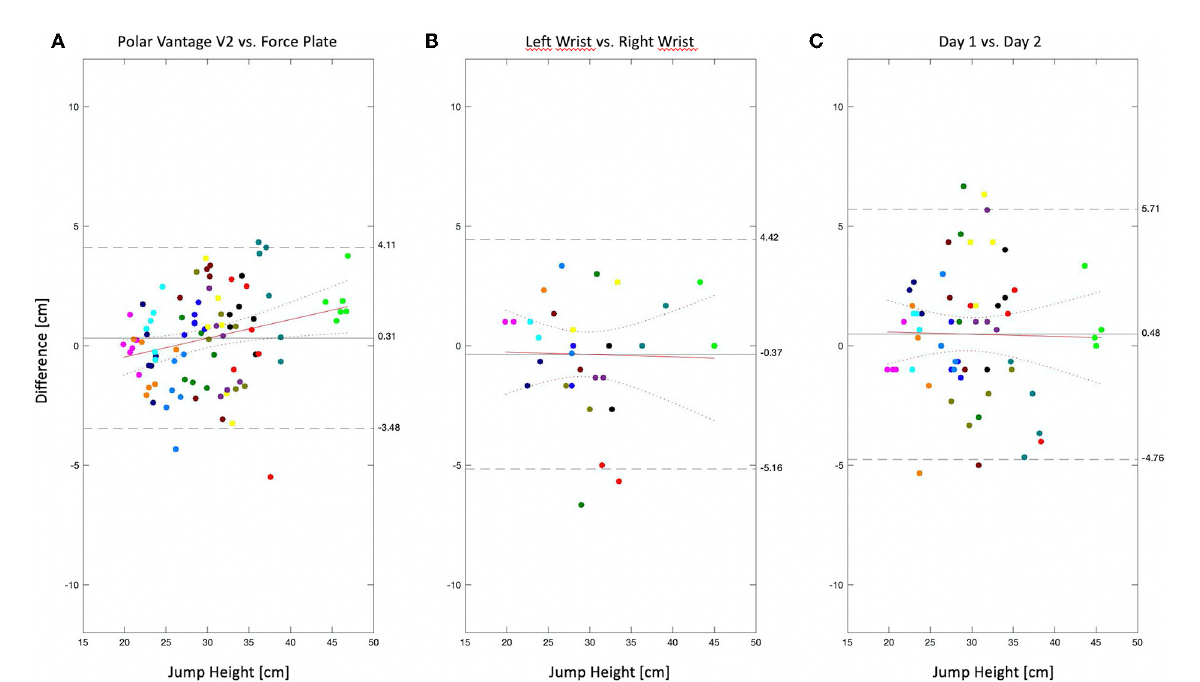
FIGURE1 Bland-Altmann plots for (A) the difference of the jump height measured by the Polar Vantage V2 sports watch compared to the force plate measurement (jump height measured by force plate data—jump height measured by the Polar Vantage V2). (B) The left-right difference in CMJ-height when wearing one watch on the left and another watch on the right hand simultaneously (jump height measured by the Polar Vantage V2 on the left wrist – jump height measured by the Polar Vantage V2 on the right wrist) and (C) the day-to-day difference in CMJ-height (jump height measured by the Polar Vantage V2 on day 2 – jump height measured by the Polar Vantage V2 on day 1). The OLS regression lines are indicated as solid red lines with the 95% confidence intervals indicated as red dotted lines. The limits of agreement are marked as dashed black lines and given in numbers on the right side of the three plots together with the bias (mean of the differences) marked as solid black line. Same colored dots represent the mean of three jumps of one participant. Values are plotted over the CMJ-height derived via the flight time method from the force plate